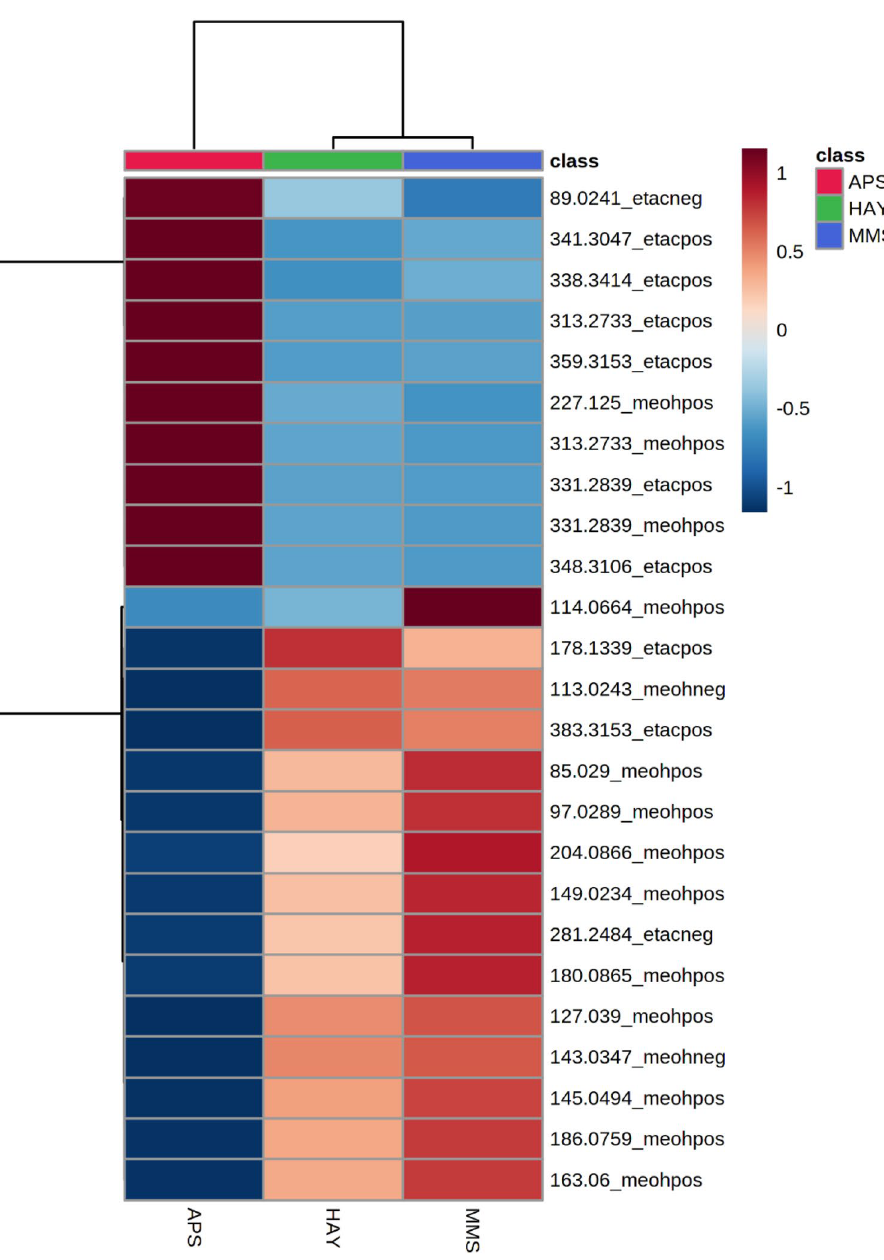
Figure 3. Heatmap obtained by hierarchical clustering analysis (HCA) of the selected milk (+ /−) DART-HRMS ions. The red (positive) and blue (negative) colour scales indicate the degree of correlation between metabolic ions and feeding system; the two shorter Pearson’s distance-tree clusters among the feeding systems (columns) and metabolites (rows) are represented by the branch height (the lower a node is vertical, the more similar its subtree